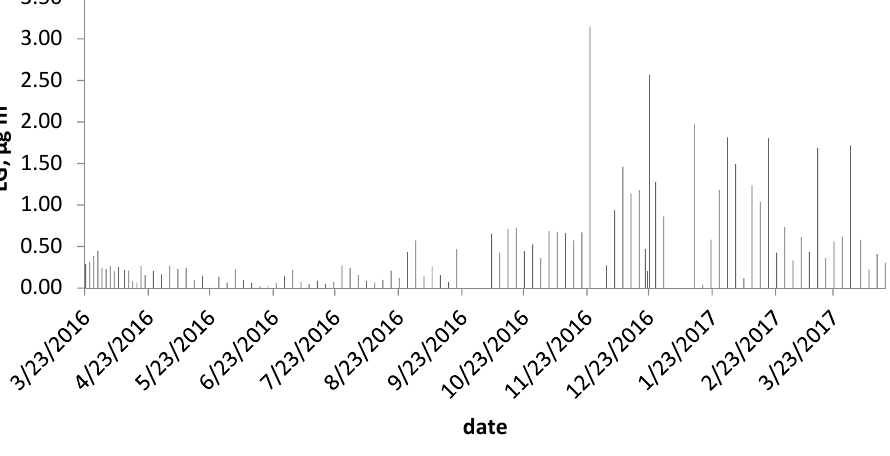
Figure 7. Seasonal variation of levoglucosan concentration at the site.